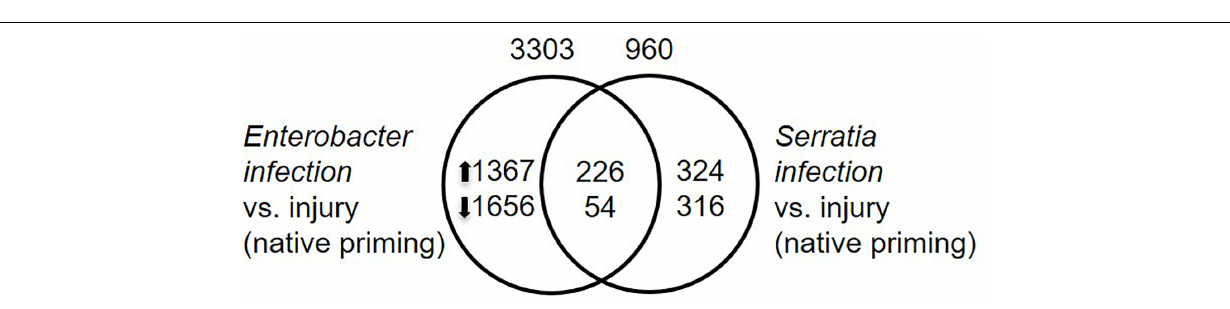
Figure 1 . In the case of Enterobacter challenges, the cohort